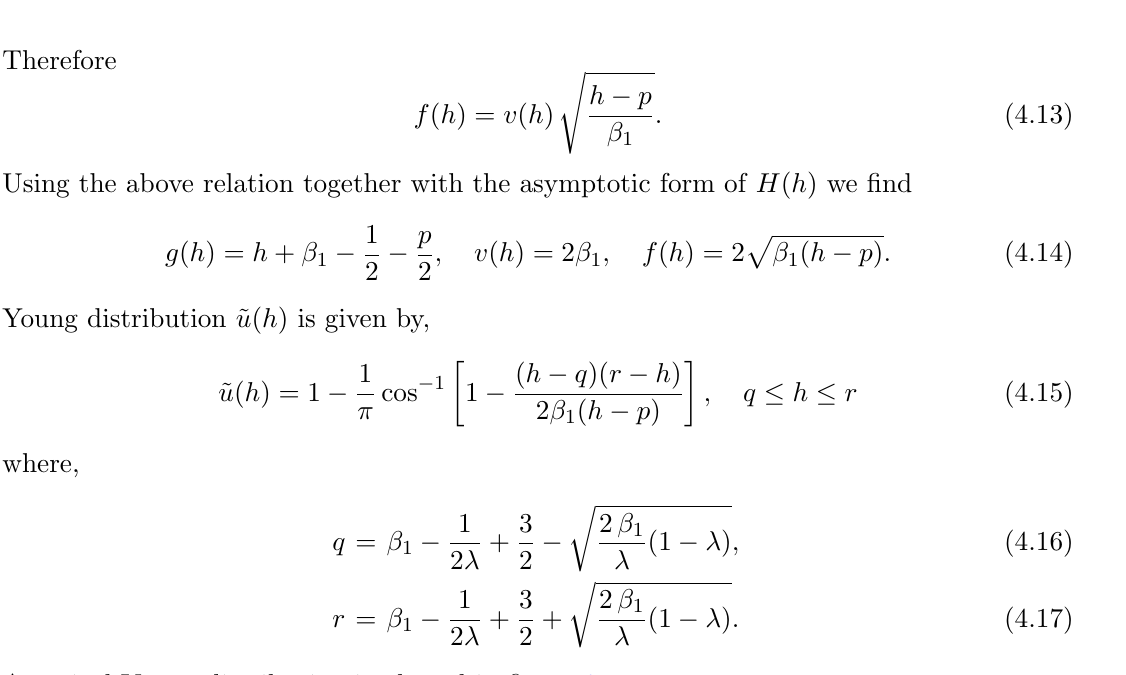
Figure 8 . u ( h ) vs. h for upper-cap